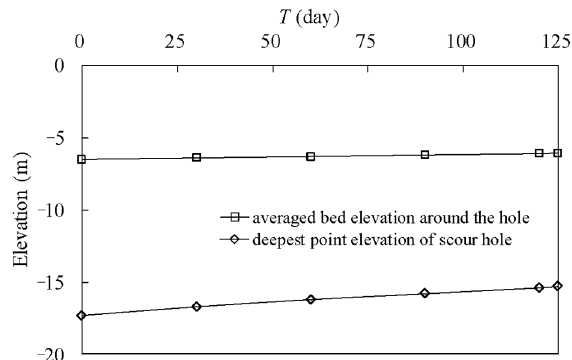
16 of 20 Figure 18. River-bed morphology changes in the confluence: ( a ) T = 0; ( b ) T = 30 days; ( c ) T = 60 days; ( d ) T = 90 days; ( e ) T = 120 days; ( f ) T = 125 days. Both the flood and ebb tides contributed to shaping the confluence scour hole. The former gave rise to deposition, while the latter led to erosion. However, the flood tide played a dominant part in the process. As a result, the scour hole shrank both upstream and downstream as time elapsed. Two factors accounted for the morphological feature. On one hand, the change was associated with the sediment availability in each river. The field measurements indicated that the flood tides carry a large amount of suspended load upstream. When flow velocity fell below 0.8 m/s, deposition occurred in the confluence area. Using morpho-sedimentological and seismo-stratigraphic data, Silva et al. explained a similar phenomenon of confluence deposition [15]. They found that the river sediment